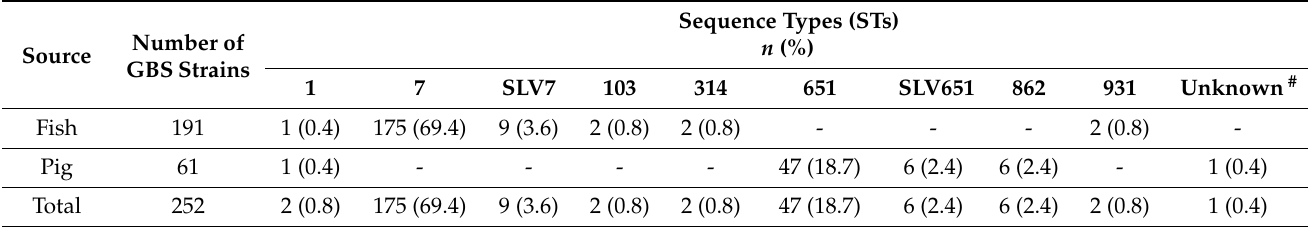
Table 4. Distribution of STs among fish and pig GBS.